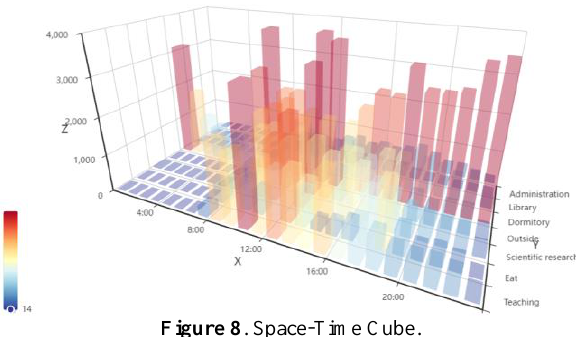
Figure 8 . Space-Time Cube.